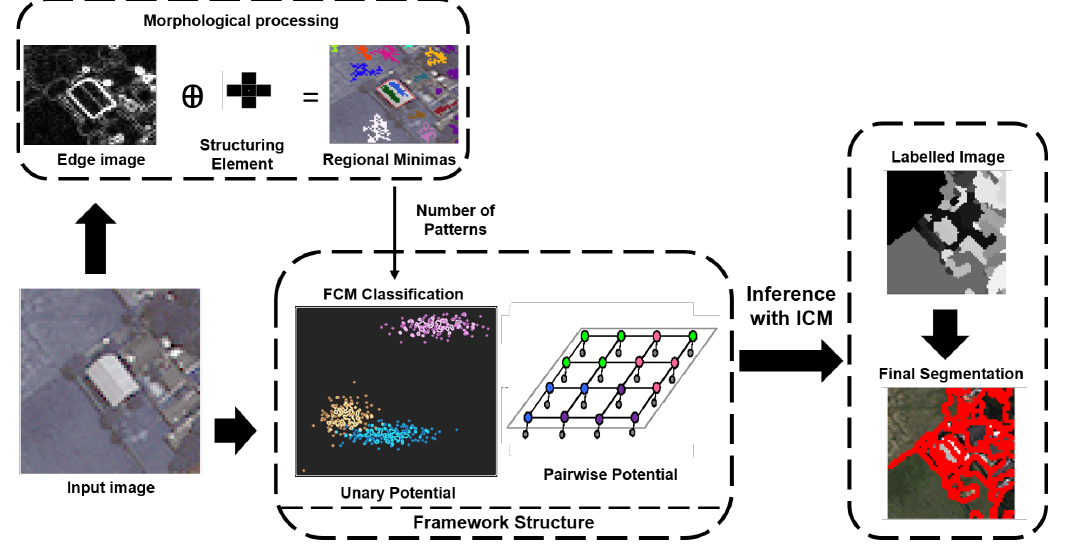
Figure 1. Image segmentation UCS segmentation